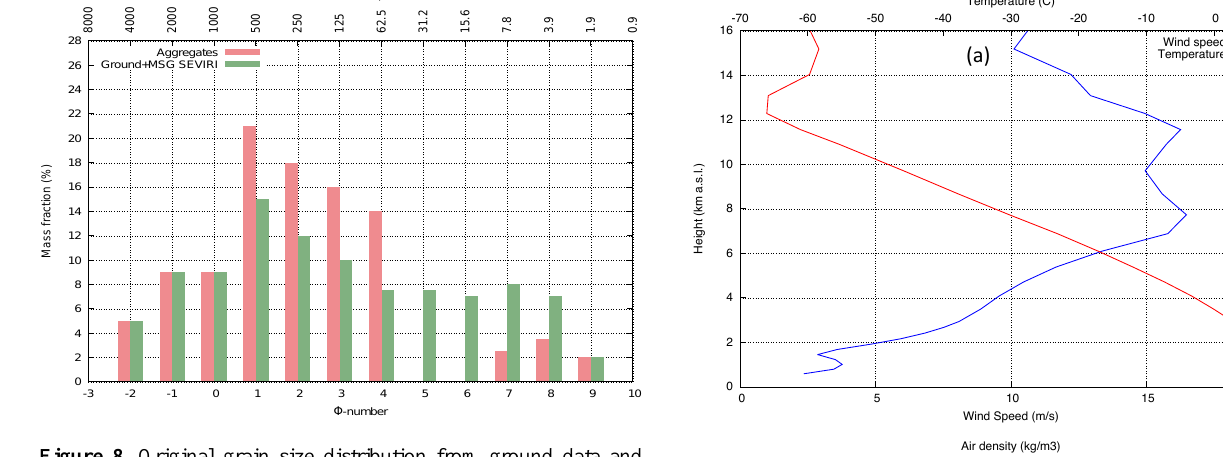
Figure 8. Original grain size distribution from ground data and MSG-SEVIRI retrievals (green) and distribution modified by ag- gregation (red). Results are for 6 May 30min averaged. Figure re- produced from Bonadonna et al. (2011) (Fig.17d). Table 5. FPLUME input values for the 6 May Eyjafjallajökull sim- ulation. Values for specific heats of water vapour, liquid water, ice, pyroclasts and air at constant pressure are assigned to defaults of 1900, 4200, 2000, 1600 and 1000Jkg − 1 K − 1 .